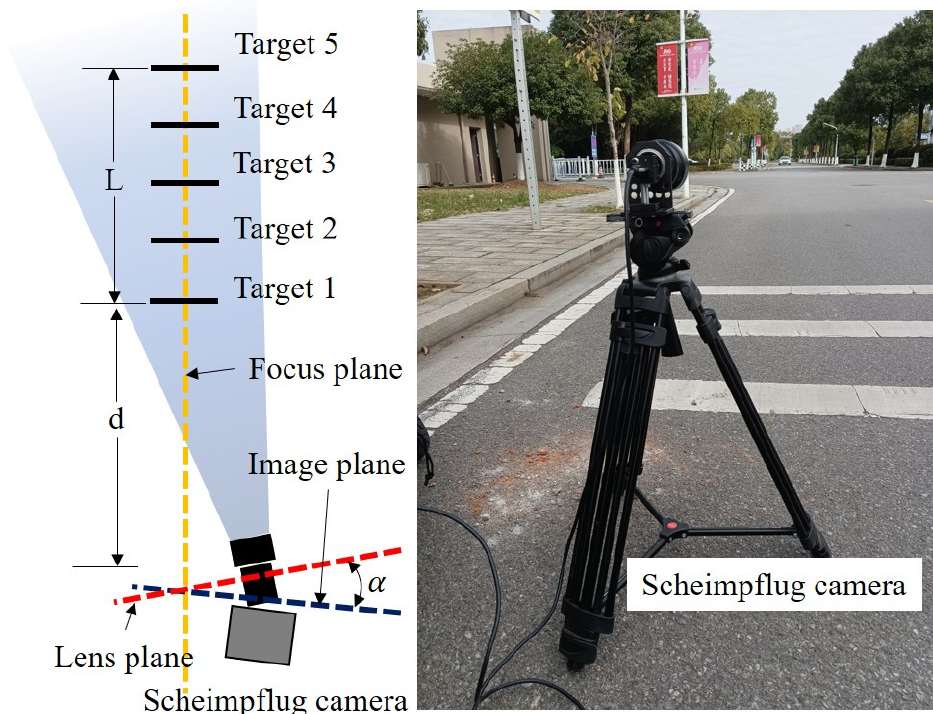
Figure 12. Experiment setup of the outdoor test.